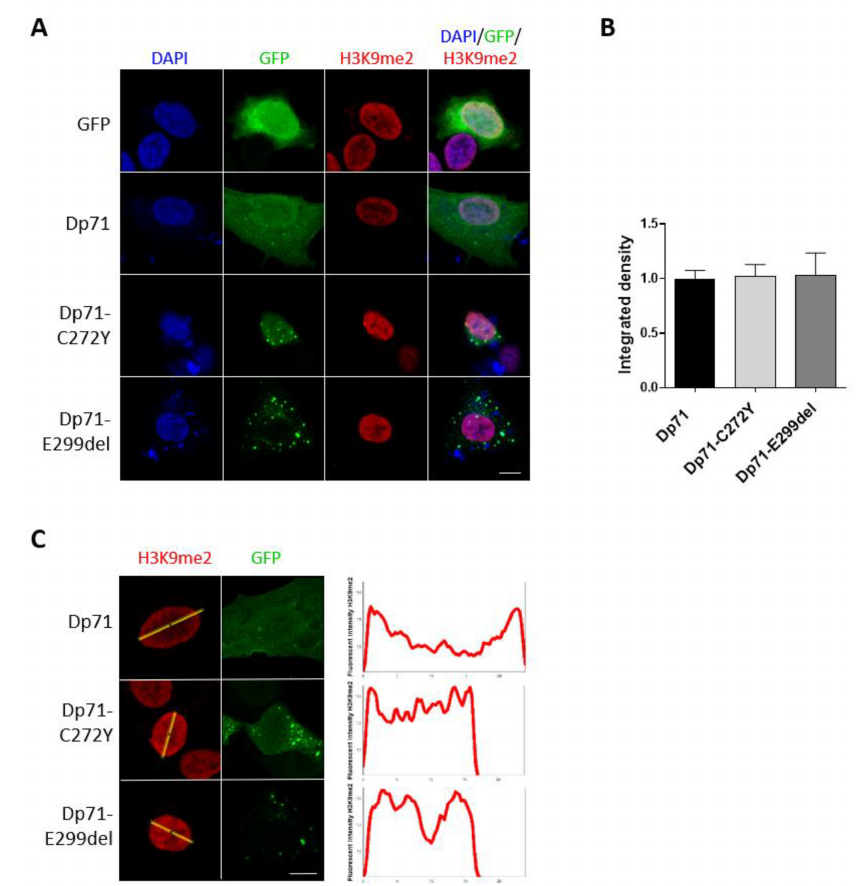
Figure 6. Distribution of the heterochromatin marker H3K9me2 is altered in SH-SY5Y cells ex- pressing Dp71 mutant variants. ( A ) SH-SY5Y cells transiently expressing GFP, GFP-Dp71, Dp71- C272Y or Dp71-E299del were immunostained for H3K9me2 and counterstained with DAPI to visu- alize nuclei. Cells were imaged by CLSM, and representative single optical Z-sections are shown (scale bar = 10 µ m). ( B ) Quantification of H3K9me2 immunofluorescence intensity was carried out in transfected cells using Fiji software. Results represent the mean +/ − SEM of three independent experiments (n = 100 cells per experimental condition). Statistical analysis was performed using one-way ANOVA and Dunnett’s multiple comparison test. ( C ) Line profile analysis of H3K9me2 immunolabeling was carried out using digitalized images and Image J 1.53a software (n = 25 cells per experimental